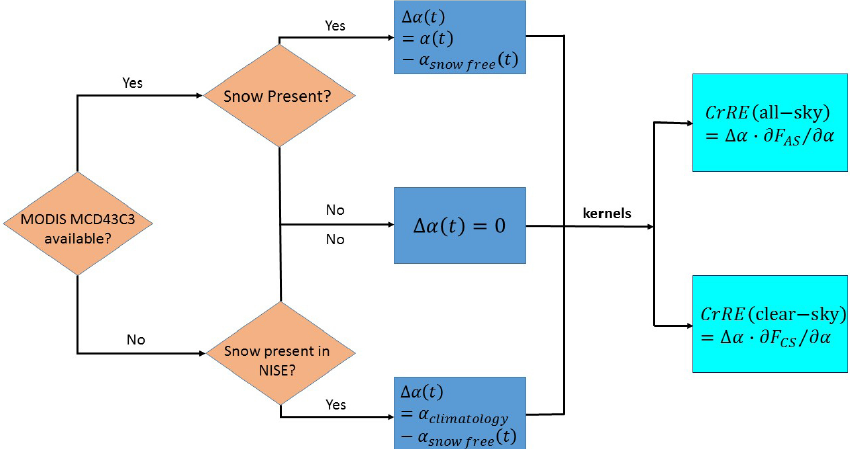
Figure 1. Algorithm for calculating CrRE.